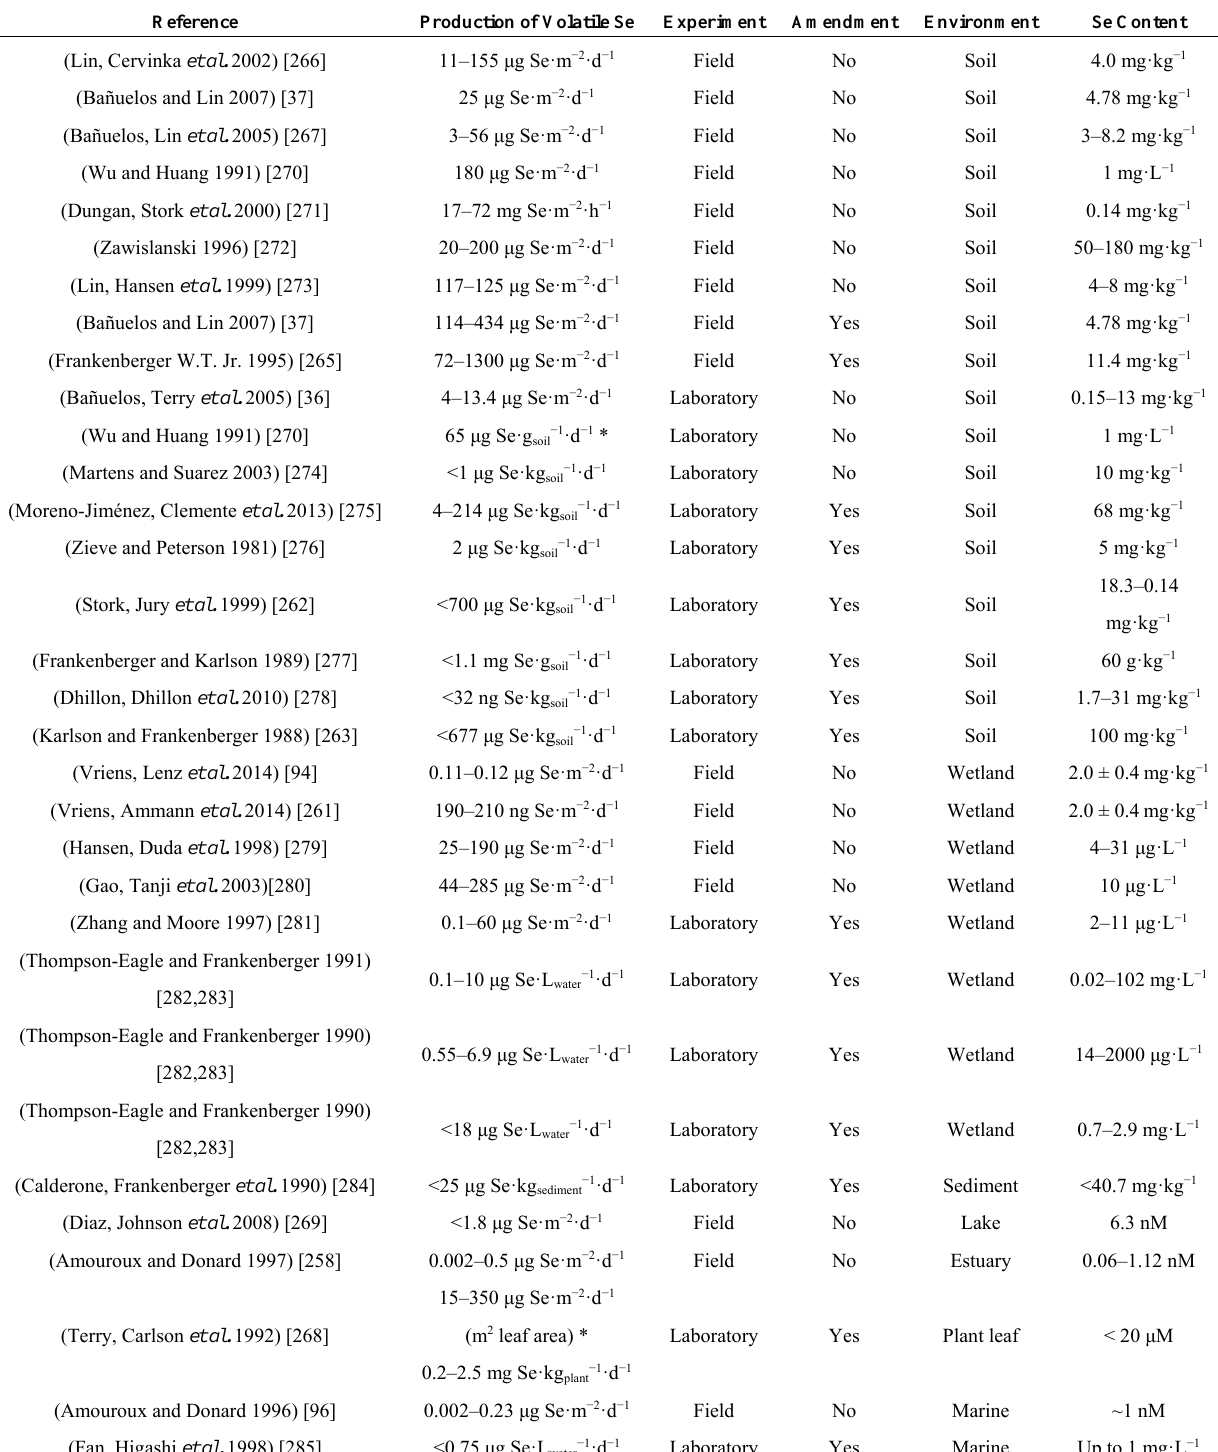
Table 2. Measurements of biogenic Se fluxes in lab and field experiments from different environmental systems (including seleniferous